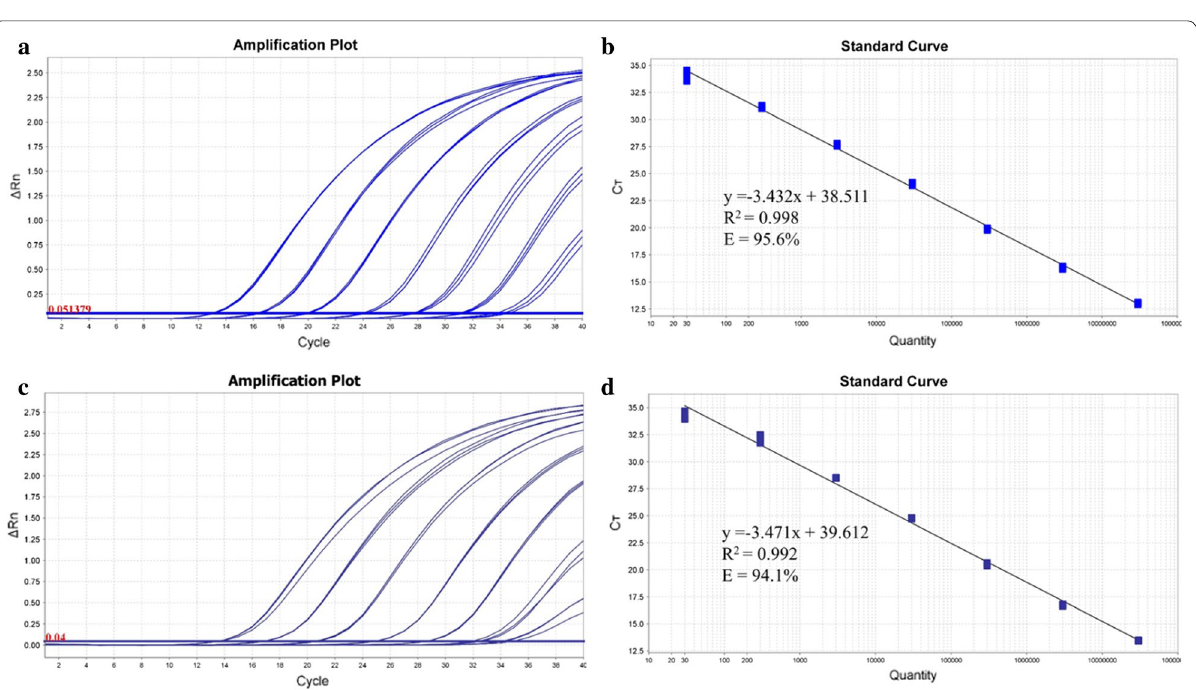
Fig. 4 Amplification plots ( a , c ) and standard curves ( b , d ) of O. scatoligenes Taqman-MGB qPCR assay with tenfold dilutions of DNA from cecal ( a , b ) or colonic digesta ( c , d ) spiked with